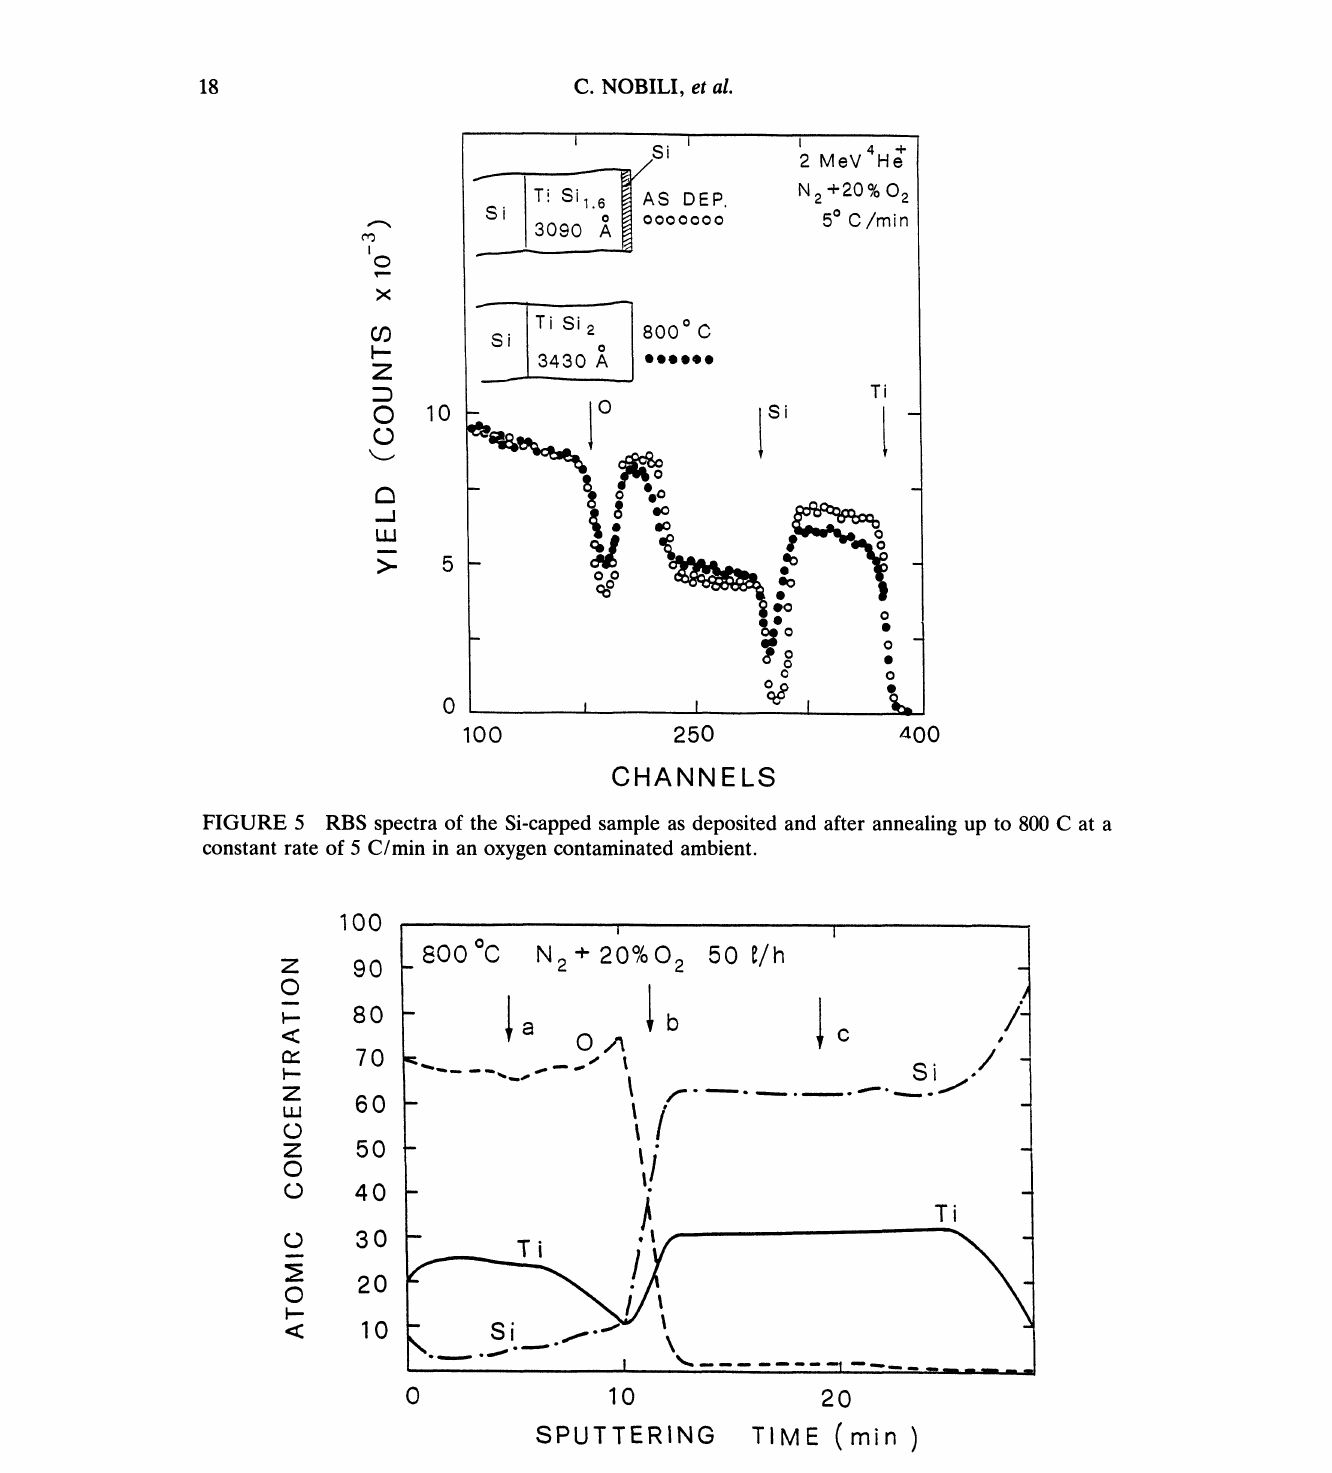
FIGURE 6 AES profile of the TiSi2. sample taken after annealing up to 800 C at a constant rate of 5 C/min in an oxygen cotaminated ambient. The arrows labelled a, b and c show the point where a whole Auger spectrum was